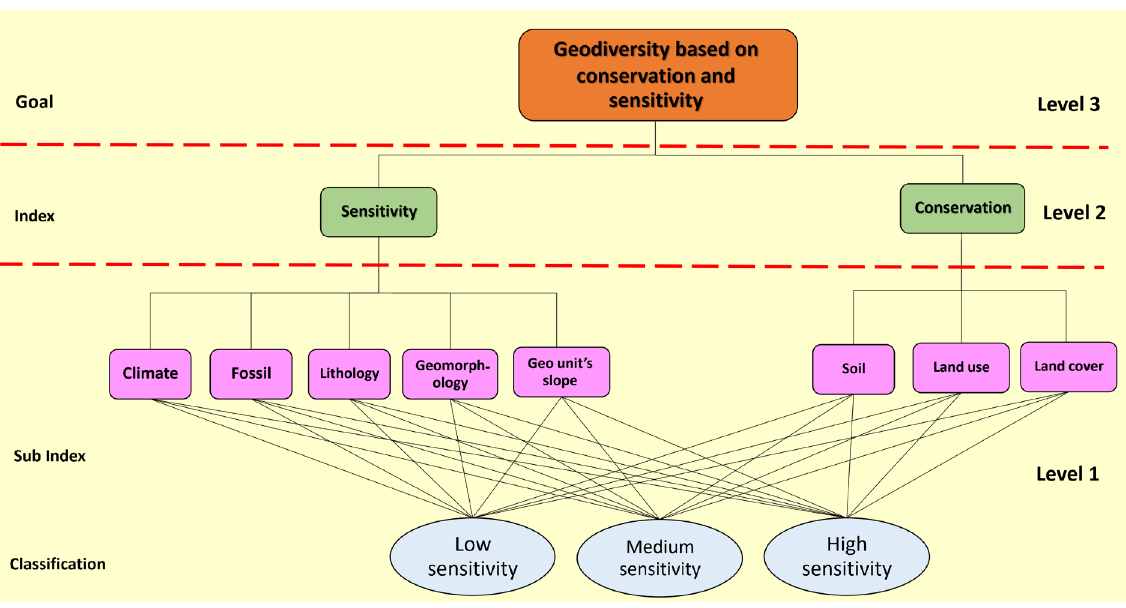
Figure 4. Diagram of geodiversity mapping